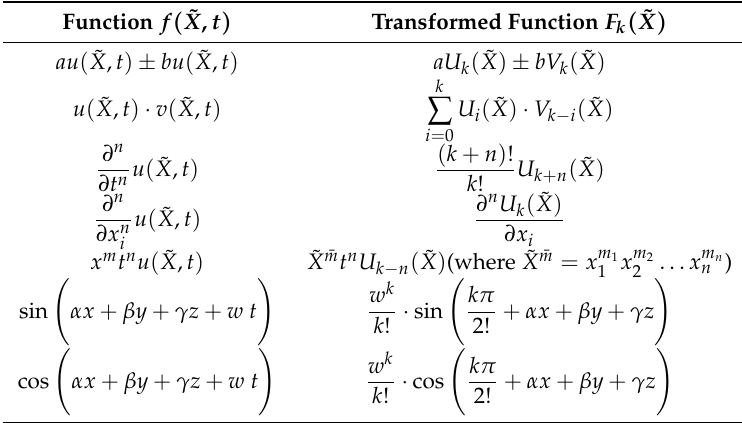
Table 4. Transformed functions using